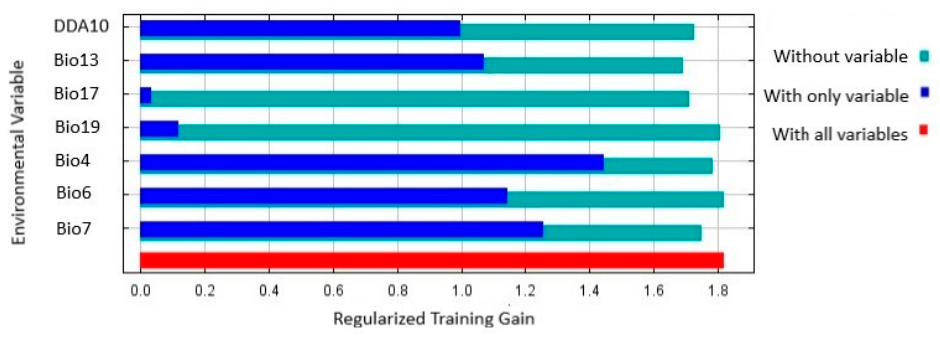
Figure 5. Jackknife test of regularized training gain of the environmental variables and DDA10 used to predict location suitability for Thaumatotibia leucotreta in Australia. DDA10 is Degree days above 10 °C.